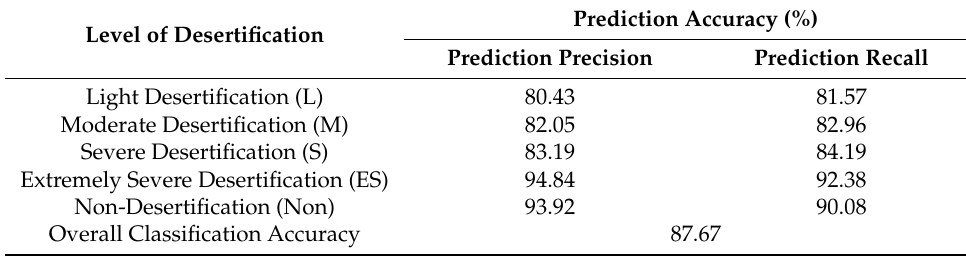
Table 5. Prediction accuracy of desertification at different levels based on random forest model. Level of